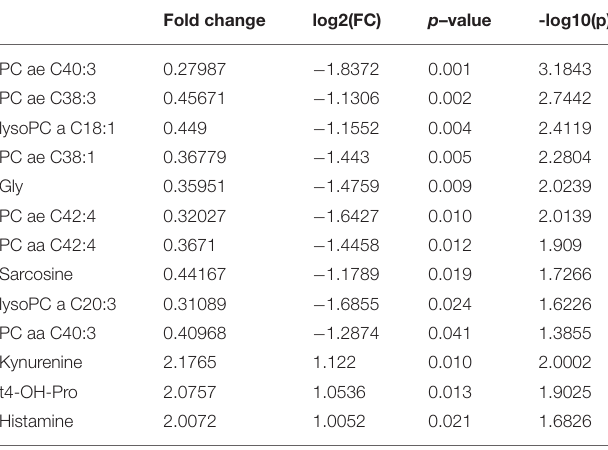
TABLE 3 | Top 13 regulated metabolites in serum among dams in the hsFLT1/rtTA mouse